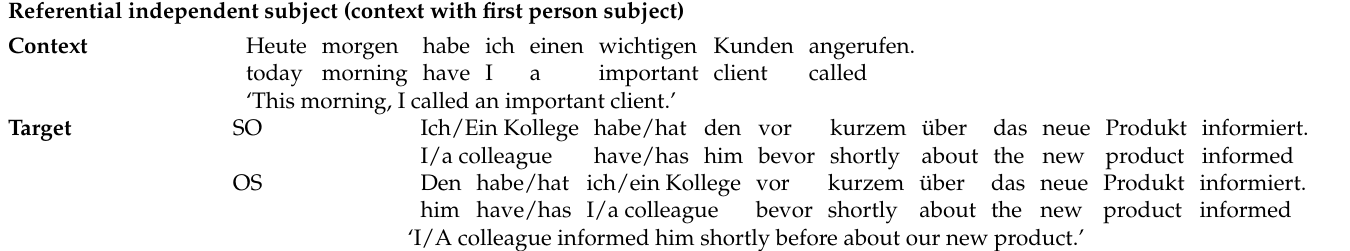
Table 3. Stimulus sentence from Experiment